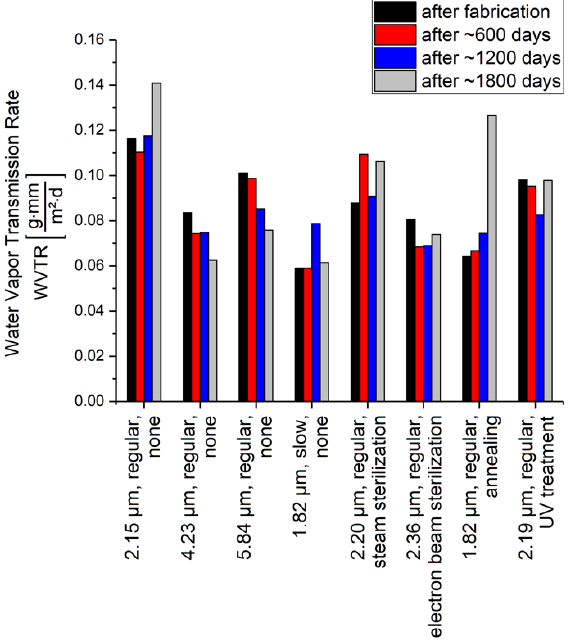
Figure 5. Results of water vapor transmission rate WVTR for the different samples and after fabrication as well as after ~600 days, ~1200 days, and ~1800 days of non-accelerated aging. For all samples, the WVTR is in or very close to the typical range of 0.06 g·mm